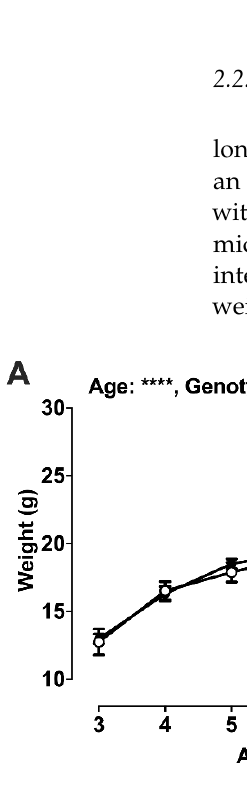
Figure 2. Post-weaning growth by sex. Weight gain from weaning (3 weeks) to 9 weeks of age in females ( A : WT, white, n = 2–12; KO, black, n = 8–13) and males ( B : WT, white, n = 6–11; KO, black, n = 2–7); 2-way ANOVA. Mean ± SEM. * p < 0.05, **** p < 0.0001, ns = not significant. Table 1. Adult post-mortem organ weights.